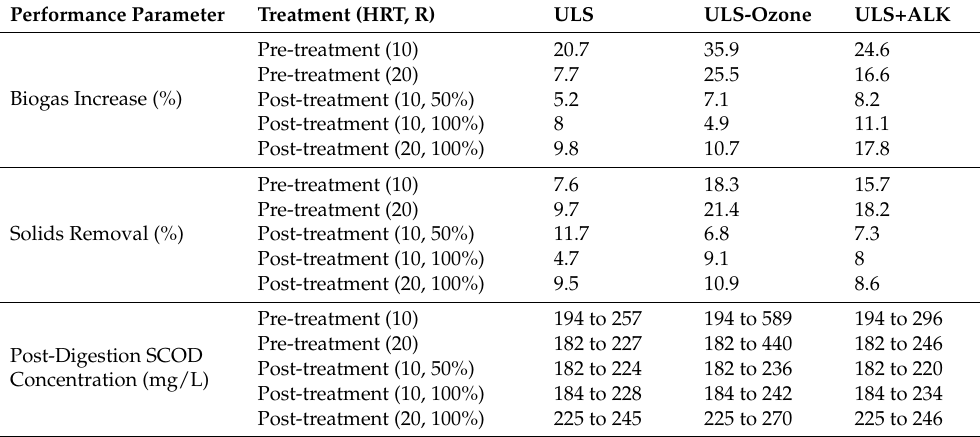
Table 5. Comparison of performance of pre-treatment and post-treatment using ULS, ULS-Ozone, and ULS+ALK treatments at 10 and 20 days